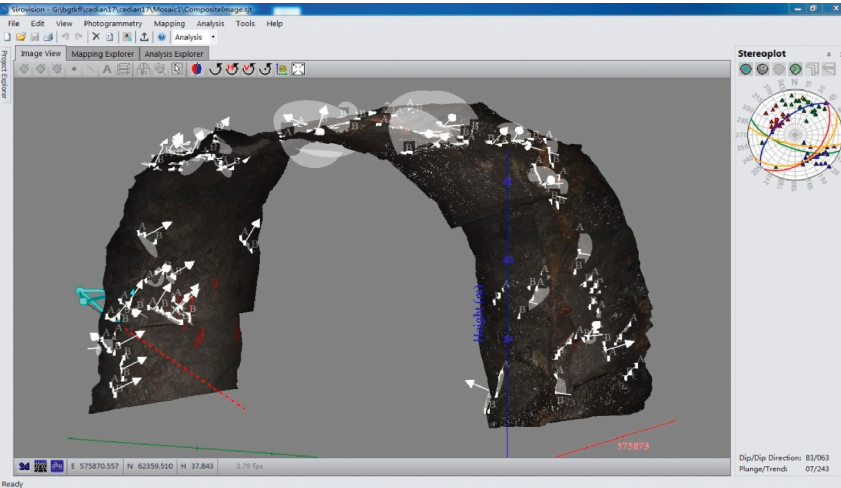
Figure 4: Sirovision stereo image analysis system.